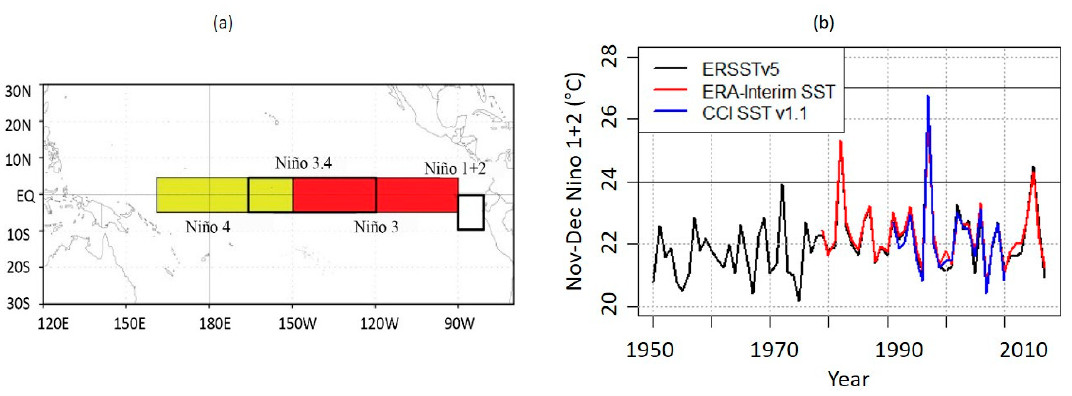
Figure 6. ( a ) The outline of regions used for assorted Niño indices [66], indicating that Niño 1+2 index is the most relevant for the area of Peru; ( b ) Time series of the ERSSTv5, ERA-Interim SST and ESA- CCI SST v1.1 Niño 1+2